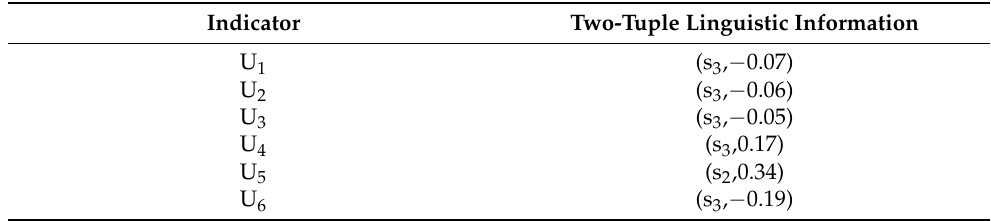
Table 4. Summary of Two-Tuple Linguistic Information of one-level